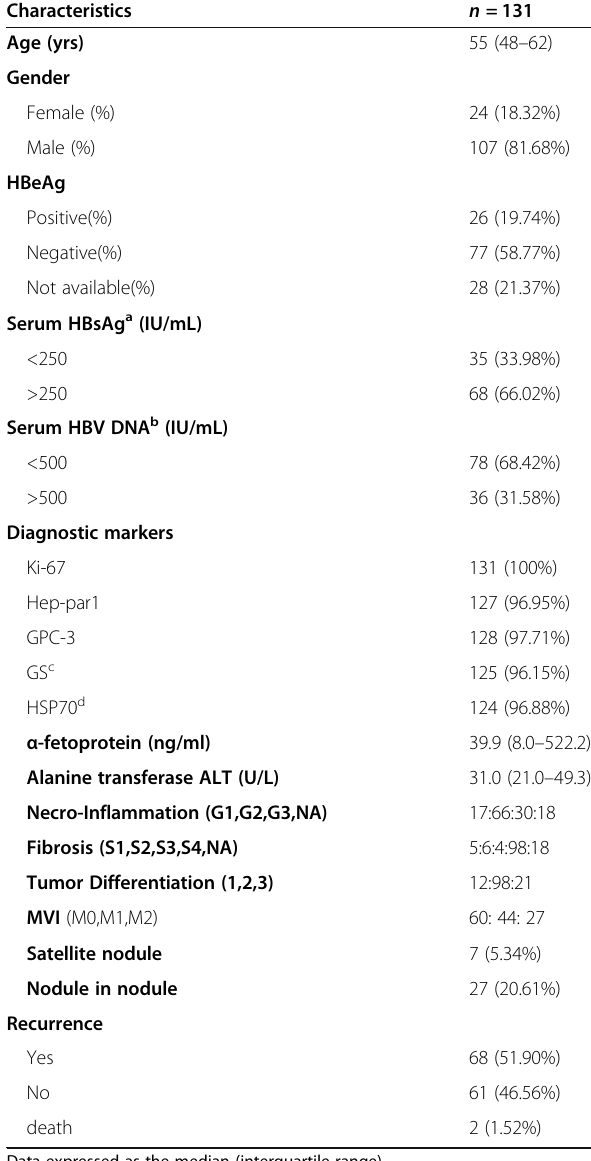
Table 1 Demographic and histologic characteristics of HCC patients